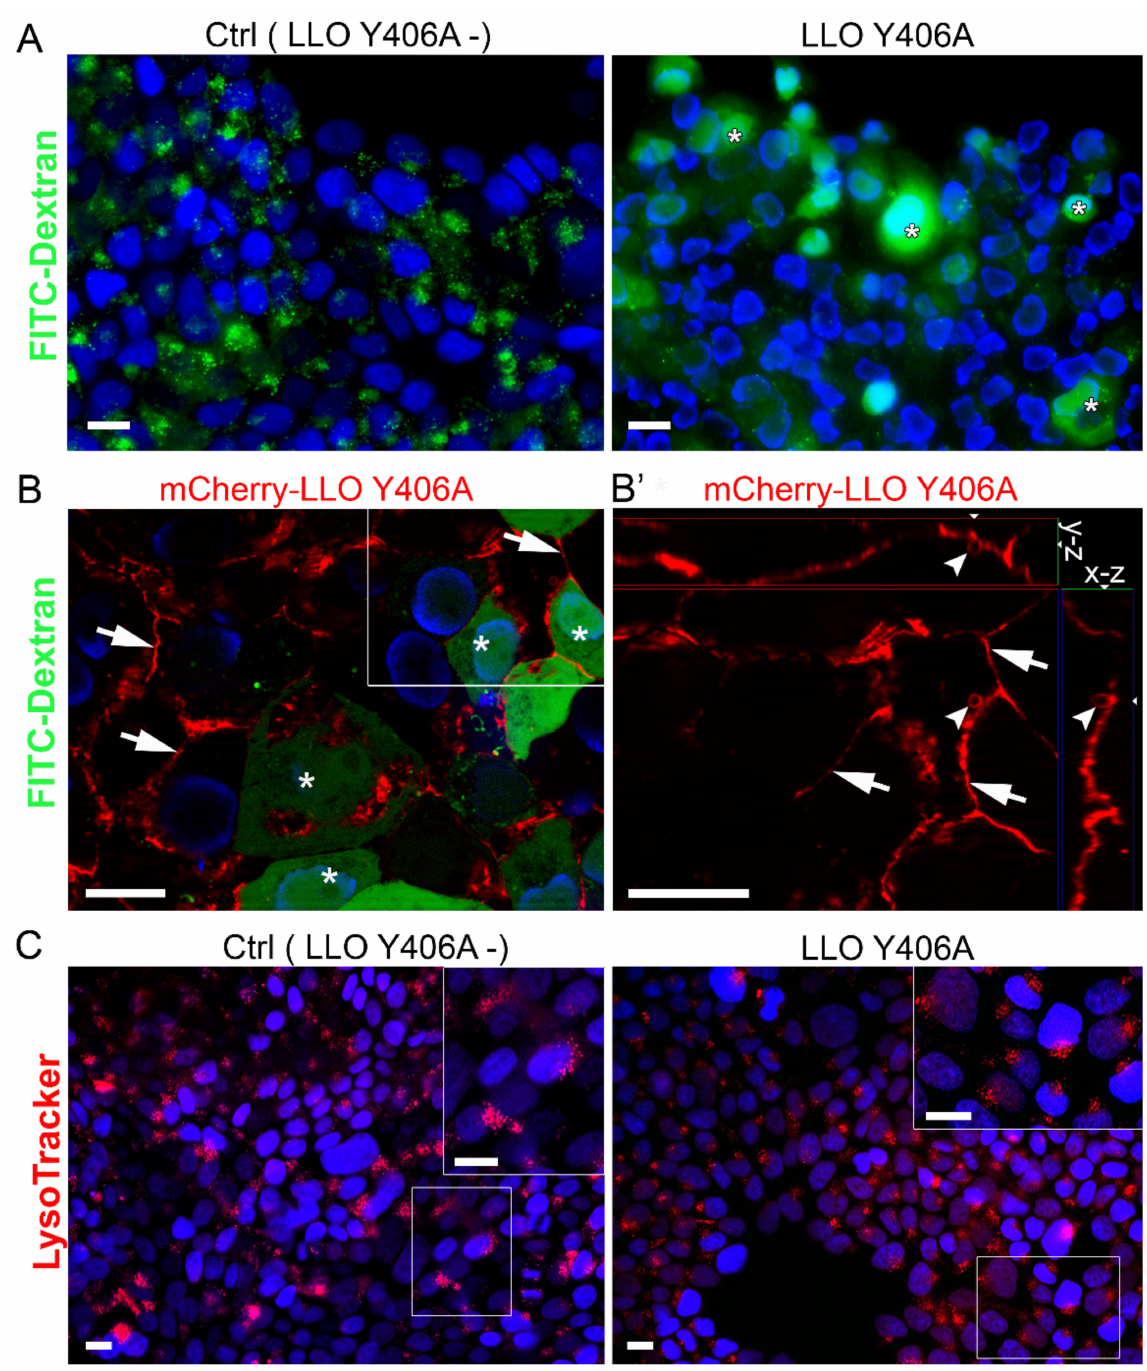
Figure 3. LLO Y406A does not cause endosomal escape, but plasma membrane perforation and blebbing in RT4 cells. ( A ) FITC-dextran shows dotted pattern fluorescence in control (LLO Y406A-) cells. After co-incubation with 0.5 µ M LLO Y406A and FITC-dextran, part of RT4 cells exhibits the cytosolic distribution of dextran (asterisks). ( B ) FITC-dextran and 5.0 µ M mCherry-LLO Y406A co-incubation results in the plasma membrane labeling with mCherry-LLO Y406A (arrows). Part of the cells shows a homogenous distribution of dextran (asterisks). ( B’ ) Magnification of the region in B (white frame) is shown in the x-z and y-z view. Plasma membrane (arrows) and extracellular vesicles (arrowheads), emanating from the plasma membrane, are labeled with mCherry-LLO Y406A. ( C ) The distribution of LysoTracker is similar in untreated and in LLO Y406A-treated cells and has a dotted pattern shown in the magnified insets. Nuclei are stained with DAPI (blue). Scale bars are 20 µ